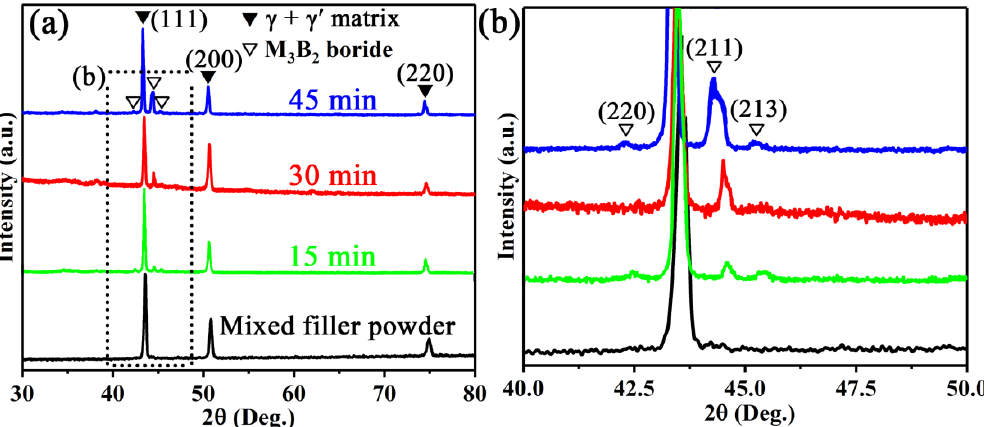
Figure 3. Backscattered electron micrographs of brazed joint ( a , b , c ) and wide-gap brazed (WGB) region ( d , e , f ) bonded at different brazing times. The size distribution of the M 3 B 2 phase ( g , h , i ) in the WGB region brazed at different brazing times.